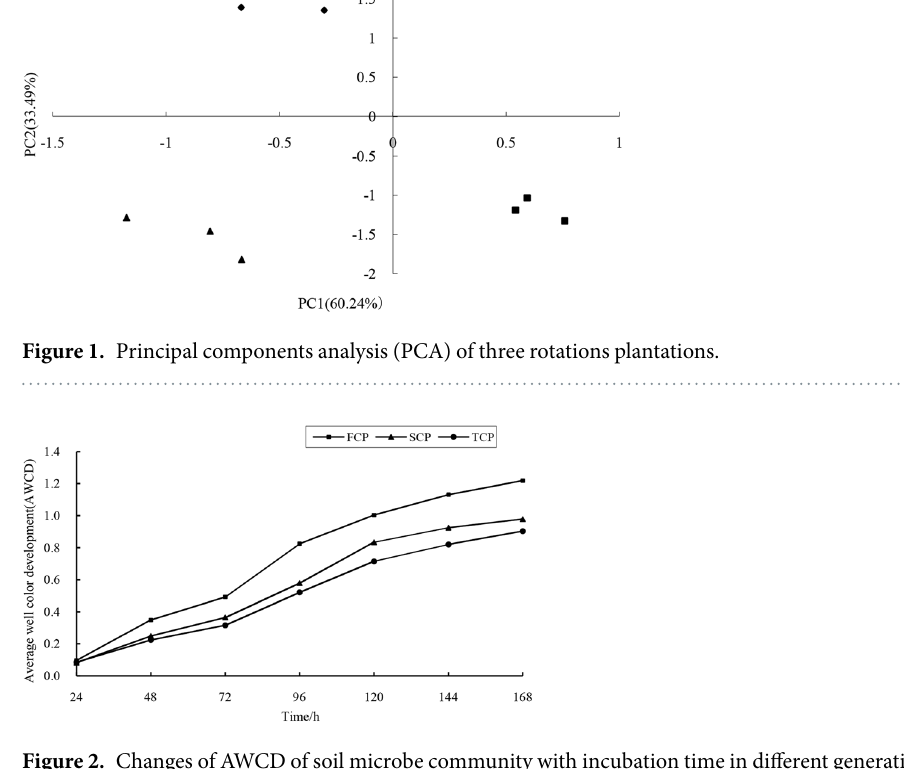
Figure 2. Changes of AWCD of soil microbe community with incubation time in different generations.